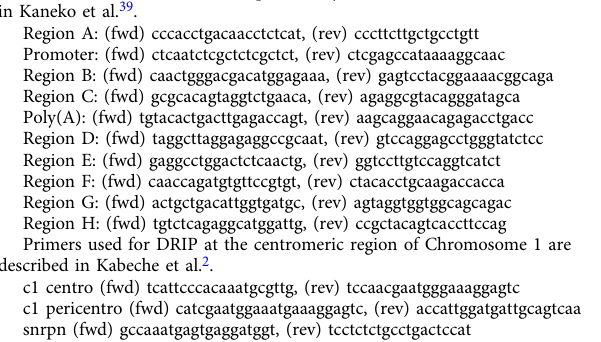
Region A: (fwd) cccacctgacaacctctcat, (rev) cccttcttgctgcctgtt Promoter: (fwd) ctcaatctcgctctcgctct, (rev) ctcgagccataaaaggcaac Region B: (fwd) caactgggacgacatggagaaa, (rev) gagtcctacggaaaacggcaga Region C: (fwd) gcgcacagtaggtctgaaca, (rev) agaggcgtacagggatagca Poly(A): (fwd) tgtacactgacttgagaccagt, (rev) aagcaggaacagagacctgacc Region D: (fwd) taggcttaggagaggccgcaat, (rev) gtccaggagcctgggtatctcc Region E: (fwd) gaggcctggactctcaactg, (rev) ggtccttgtccaggtcatct Region F: (fwd) caaccagatgtgttccgtgt, (rev) ctacacctgcaagaccacca Region G: (fwd) actgctgacattggtgatgc, (rev) agtaggtggtggcagcagac Region H: (fwd) tgtctcagaggcatggattg, (rev) ccgctacagtcaccttccag